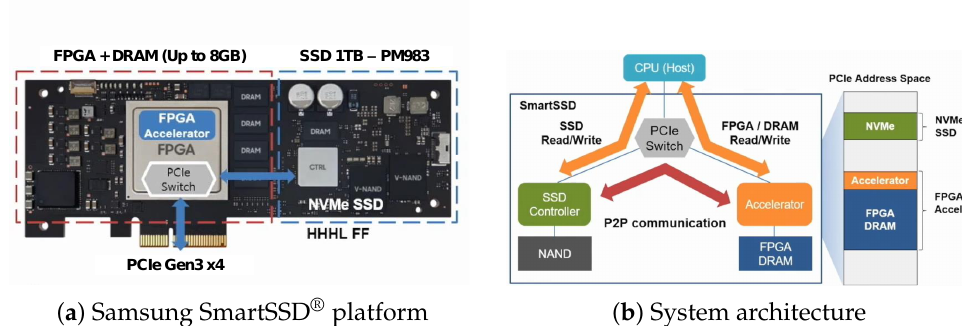
Figure 1. Samsung SmartSSD ® ( a ) hardware architecture ( b ) (Figure 1 is copyrighted by Samsung Electronics. The image was obtained with permission from https://youtu.be/OHWzWv4gCTs?t=639 (accessed on 10 October 2021)).